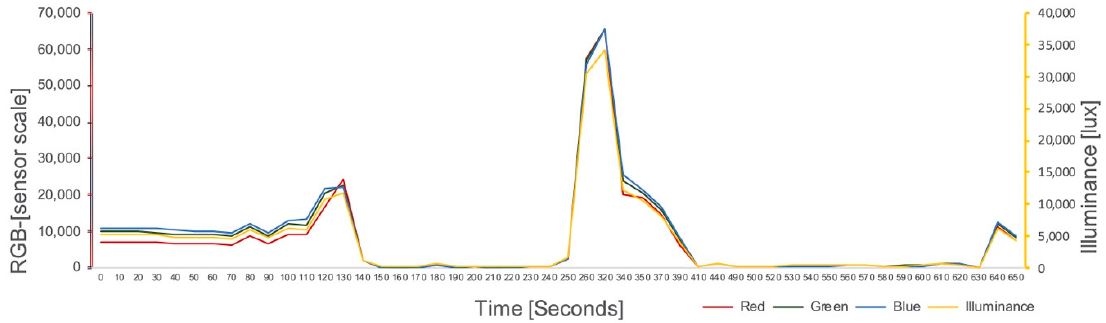
Figure 8. Comparison of red, green, blue (RGB) colors and illuminance.